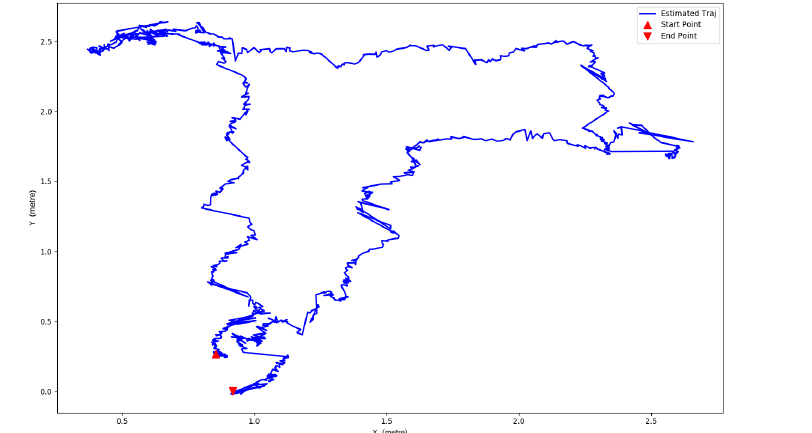
Figure 11. Closed trajectory—2nd.